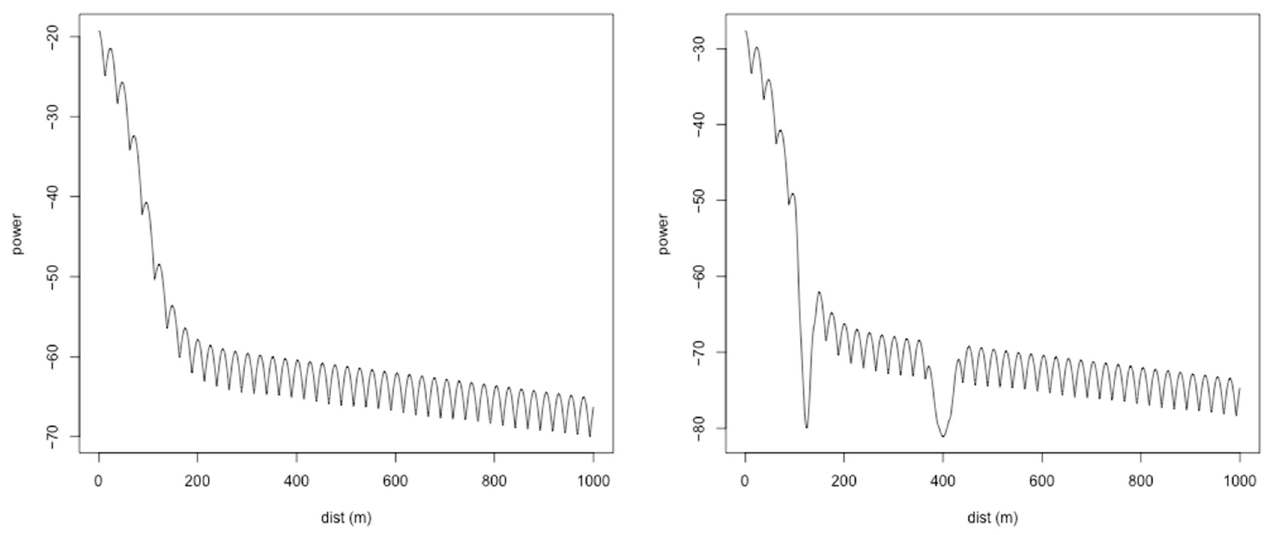
Figure 10. Examples of the results from an ad hoc propagation model. On the right-hand side, two dead zones are simulated—one around 175 m and another around 400 m.